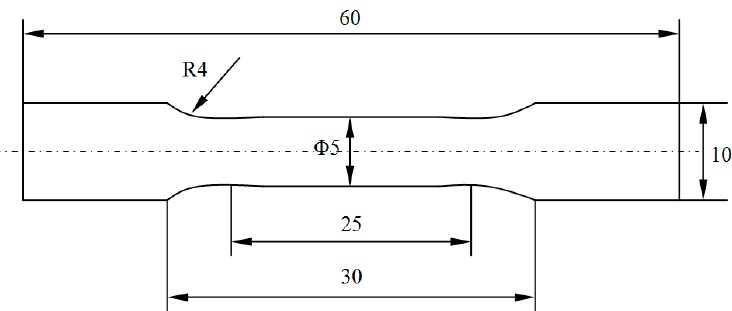
Figure 1. Sample size for tensile testing (unit: mm).